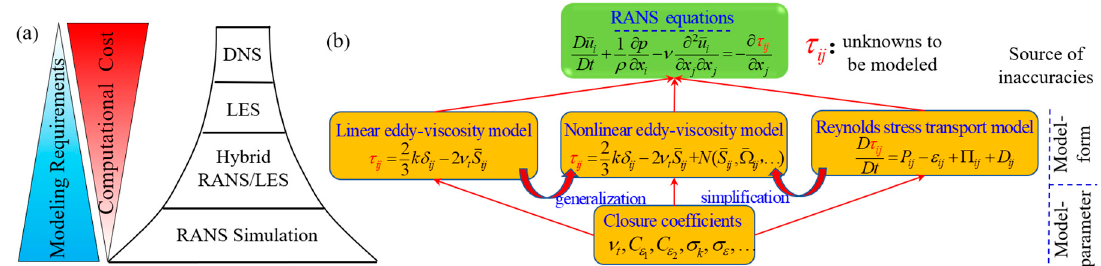
Figure 1. A schematic showing the hierarchy of turbulence simulation and modeling at the level of Navier-Stokes equations: ( a ) four classes of simulation methods based on modeling requirements and computational cost, and ( b ) three classes of turbulence models for Reynolds-averaged Navier-Stokes (RANS) closures which implied two sources of model inaccuracies due to structural (model-form) and parametric (model-parameter) inadequate representations of real physics.